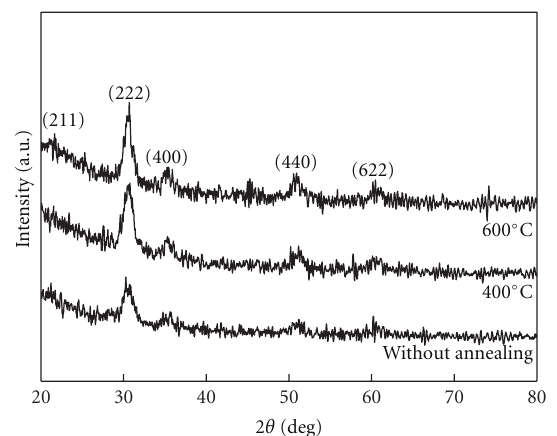
Figure 4: FTIR spectra of the ITO thin films treated without annealing and with annealing at 400 ◦ C and 600 ◦ C in 3% H 2 /97% N 2 mixtures